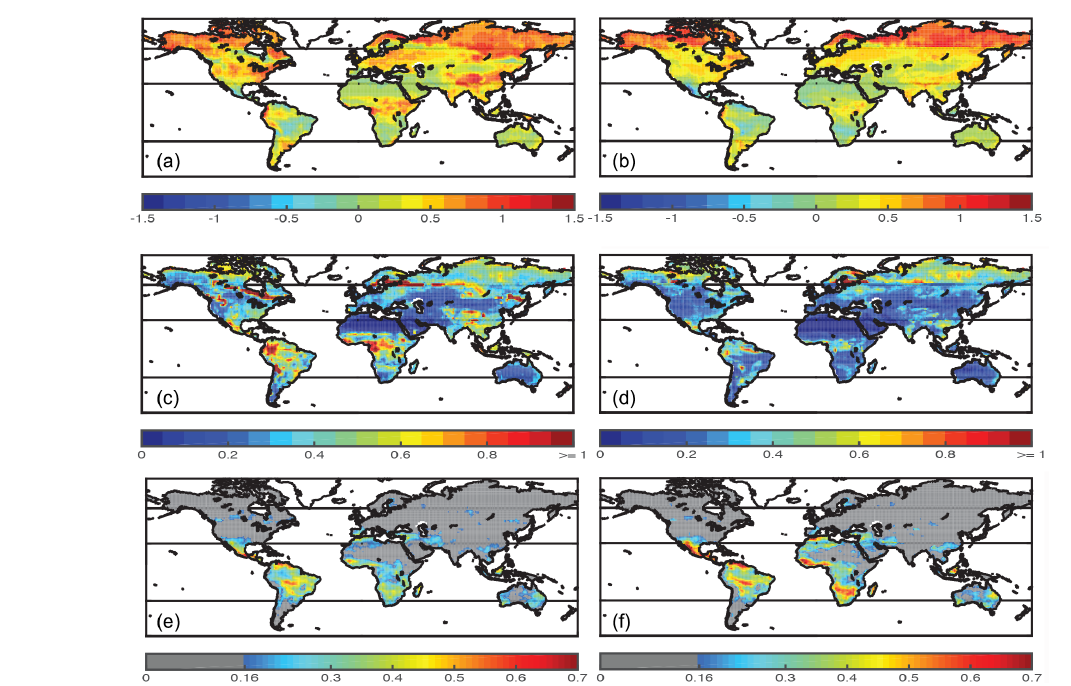
Figure 7. Mean of all models for the annual mean change in LAI over time (2081–2100) relative to current (1981–2000), normalized by each model’s current (1981–2000) standard deviation at each grid point (a) for all models (same as Fig. 1c) and (b) for the top models, defined as the models performing in the top half (Table 4) for each region, tropical, mid-latitude or high-latitude. Because different models are included in different regions, there can be discontinuities at the boundaries in Fig. 8b (e.g., 30 and 60 ◦ latitude). The standard deviation in the mean future projection at 2081–2100 across the models at each grid point are shown for (c) all models and (d) top models. Indication of “Low” LAI is the model mean fraction of the time that LAI is more than 1standard deviation below the current mean LAI and is shown for (e) all models (same as Fig. 5c) and (f) , top models for the period 2081–2100, where the current mean and standard deviation are defined for each grid box for 1981–2000. For the current climate, the fraction of the time below 1standard deviation will be 0.16, which is colored in gray, so all colors represent an increase in